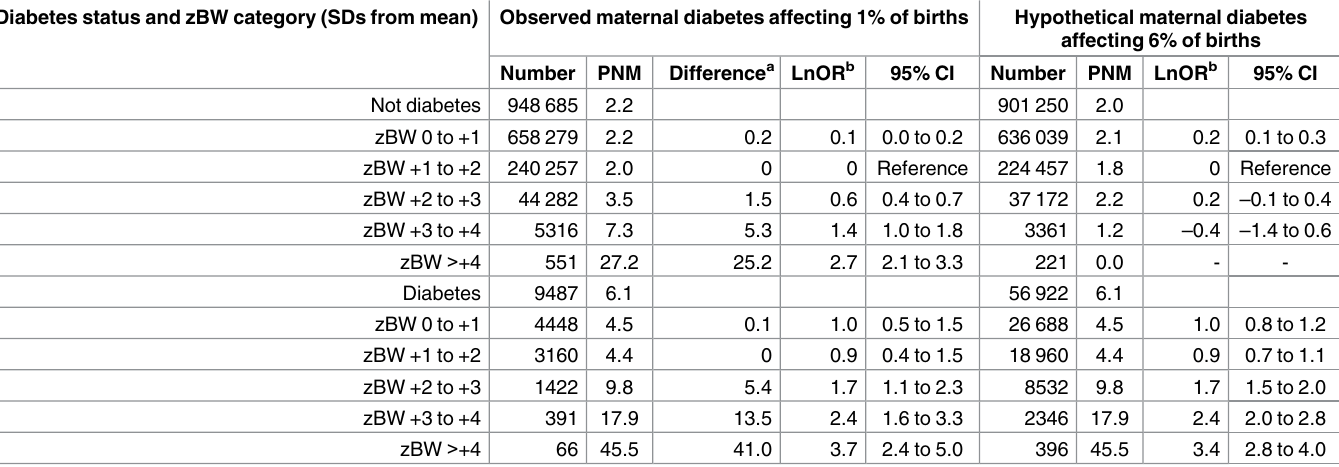
CI: confidence interval; PNM: perinatal mortality per 1000 births; OR: odds ratio; SD: standard deviation; zBW: z-score birth weight, standardized for year of birth, sex, birth order, gestational week, and plurality. a PNM difference between category and reference category (zBW +1 to +2).